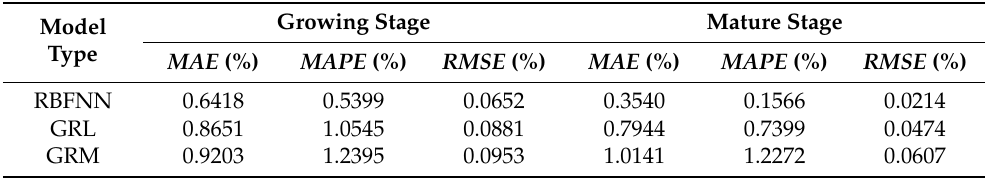
Table 2. Comparison of the performance of prediction models.